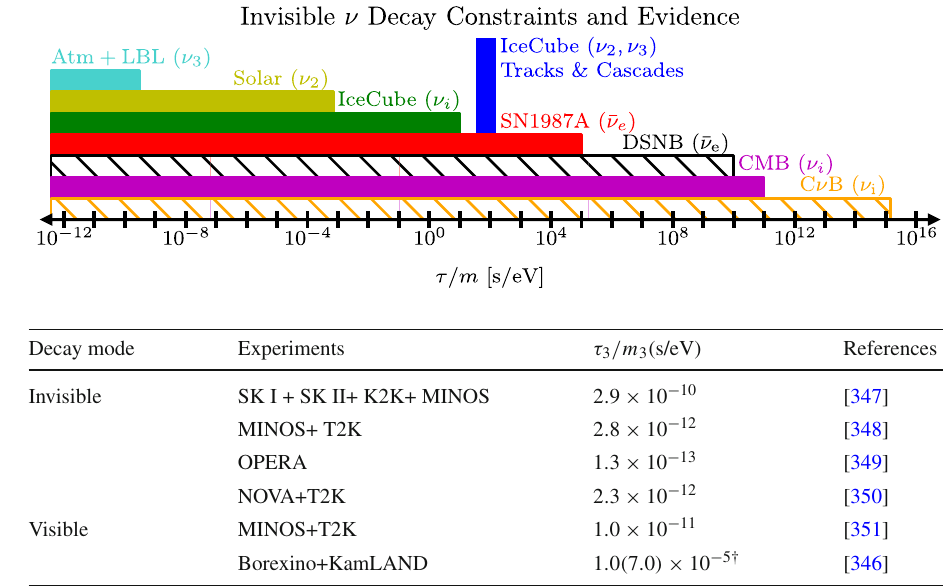
Fig. 5 Constraints on invisible neutrino decay from several experiments [229,330–334]. The blue region represents a hint for neutrino decay [328,335] in IceCube data. Dashed regions represent anticipated sensitivities from future measurements. Figure adapted from [328]